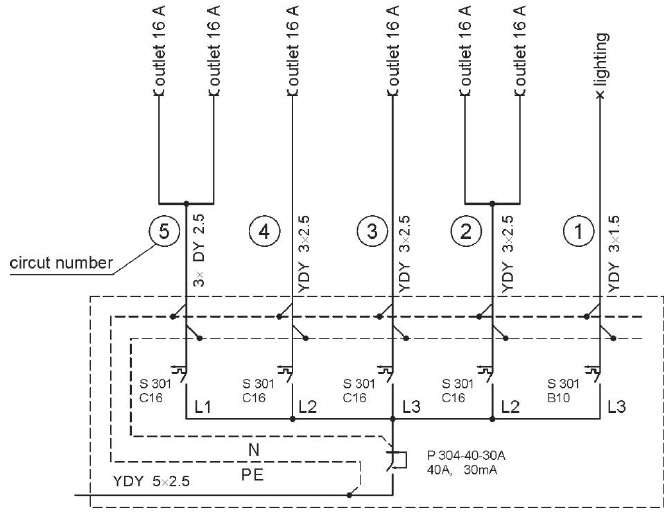
Figure 10. Scheme of electrical circuits of tested samples.